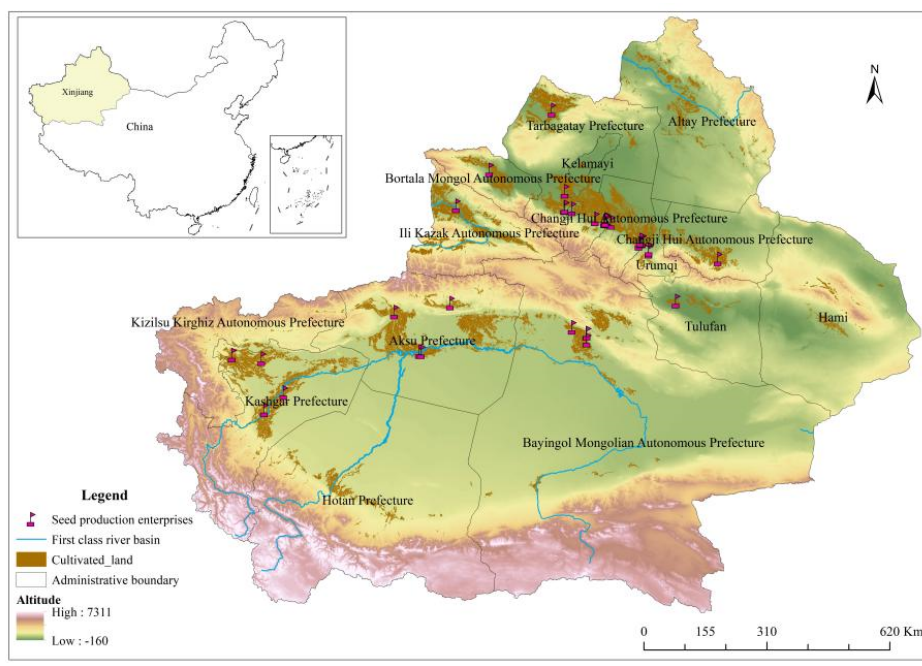
Figure 1. Study area and spatial distribution of cotton seed production enterprises and cultivated land.